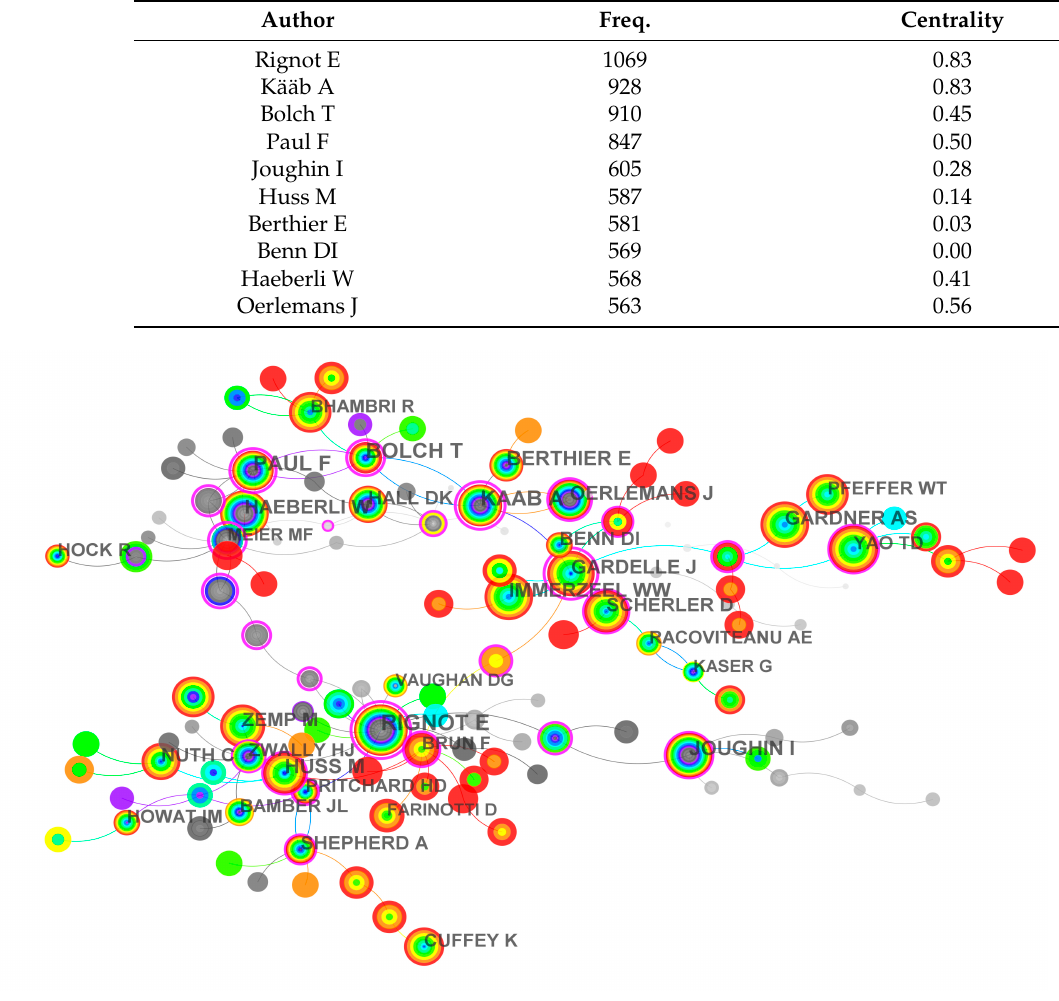
Table 4. Top ten productive authors.